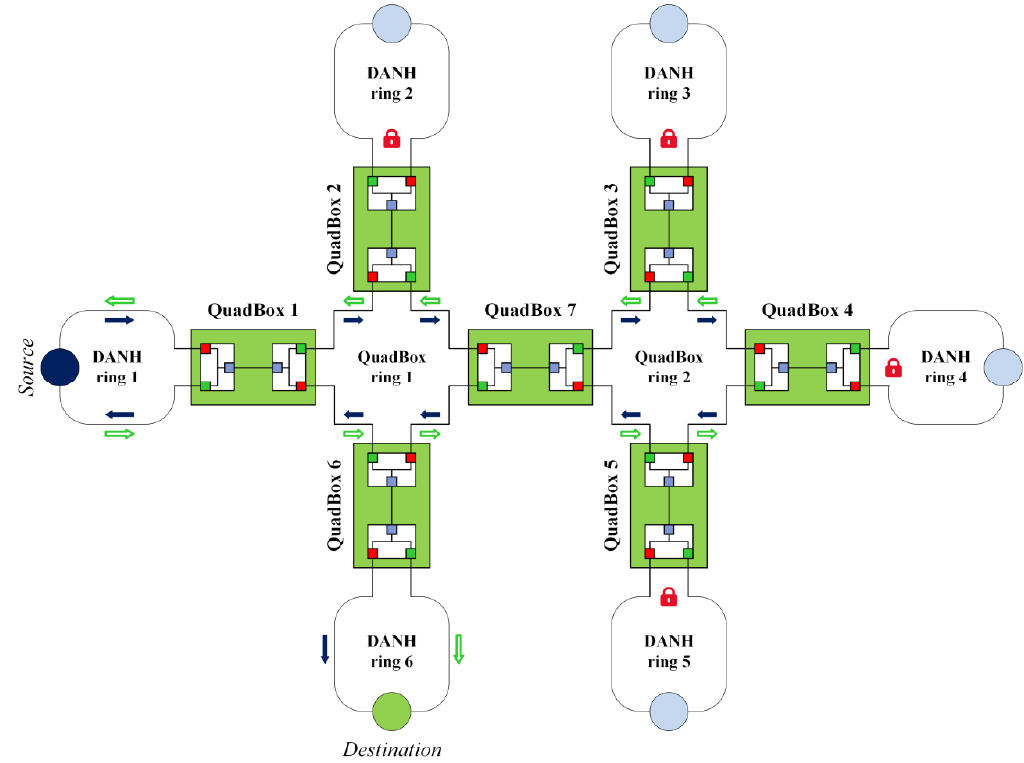
Figure 7. Filtering unicast traffic under the PL